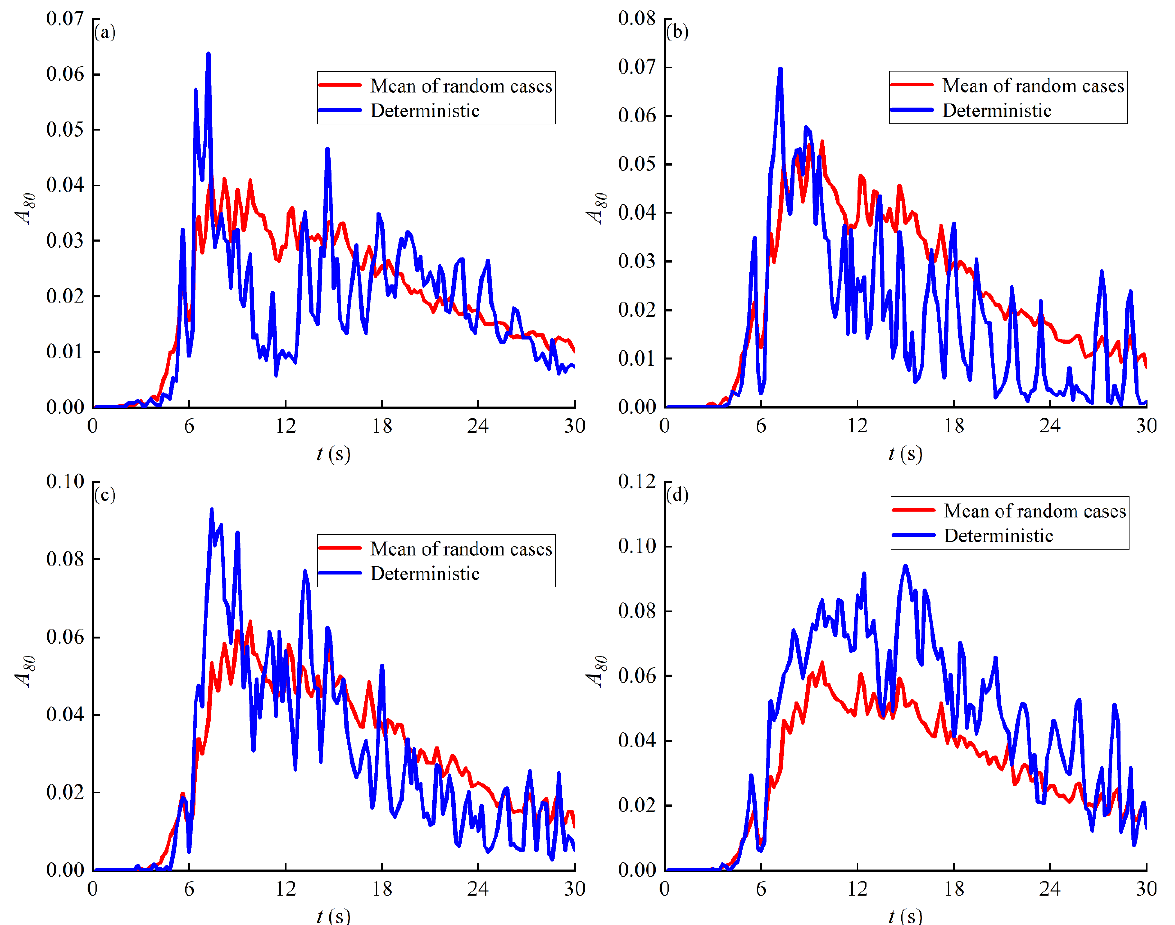
Figure 7. Variation of A 80 with time history under different embedment depths of tunnel: ( a ) H = 6 m; ( b ) H = 8 m; ( c ) H = 10 m; ( d ) H = 12 m.